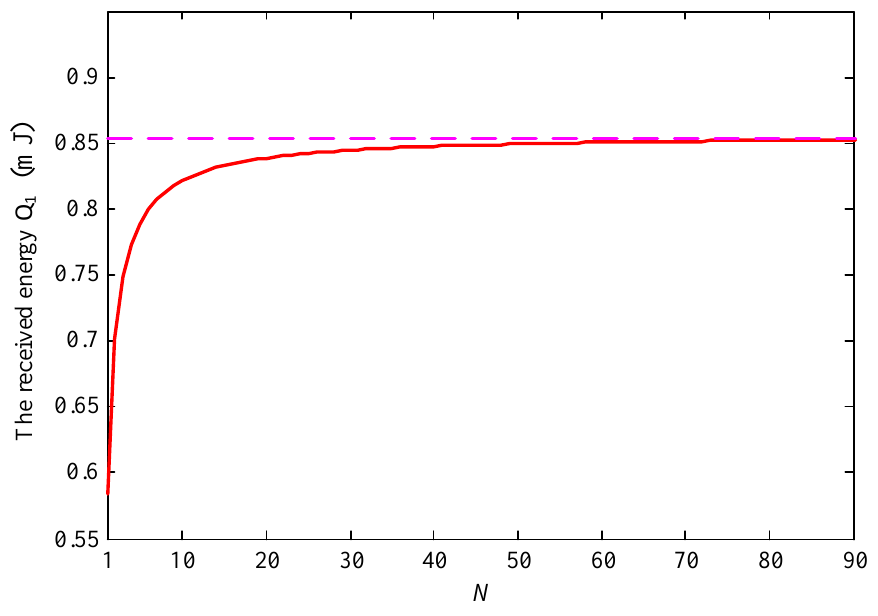
Figure 5. Convergence analysis of the proposed